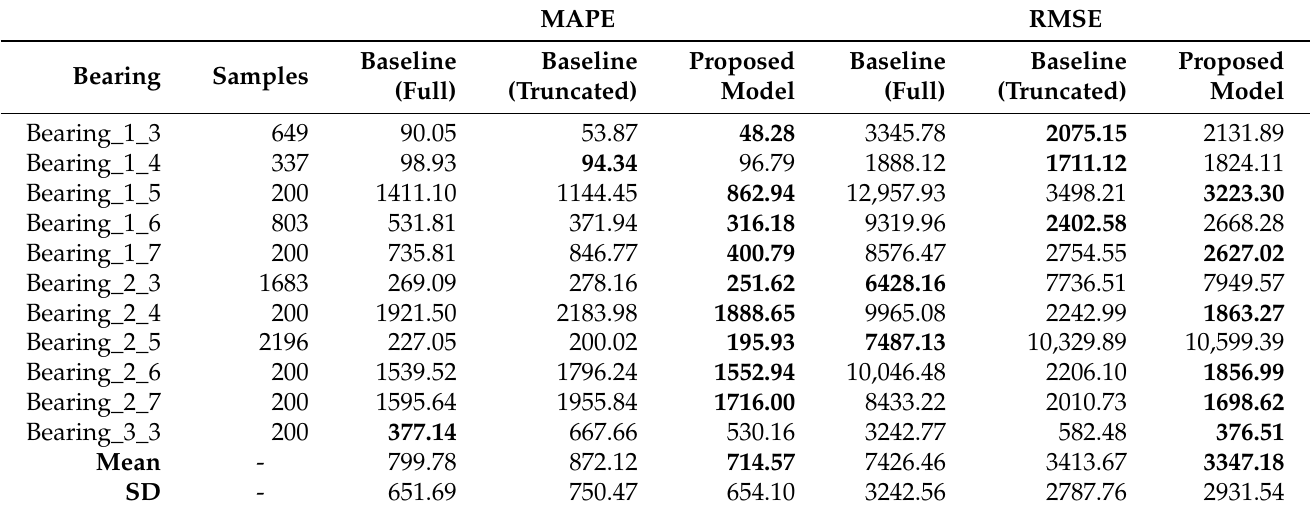
Table 6. Results obtained on the PHM dataset. Highlighted in bold the best result per bearing.